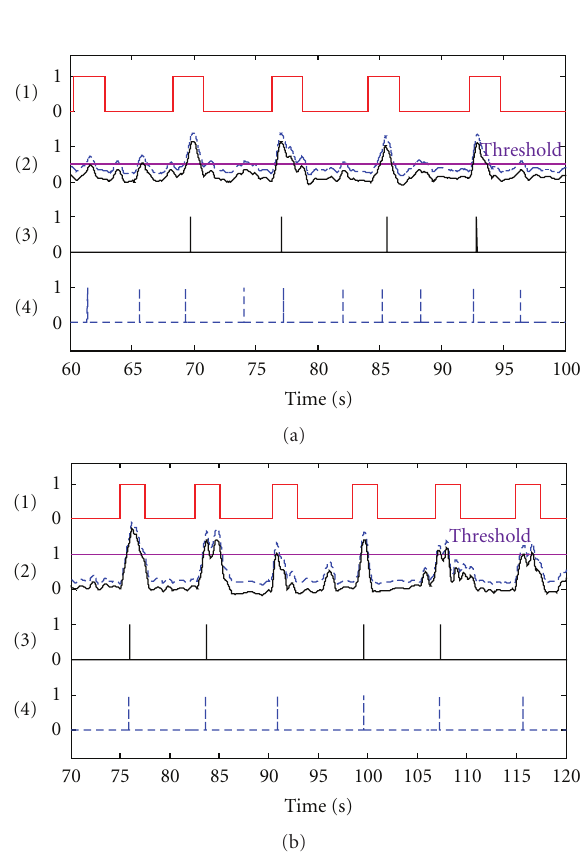
Figure 6: An example of comparison between biased and debiased classification output in detecting the onset of the movement: (1) IC intervals, (2) dashed line: biased classification output and straight line: debiased output. (3) Detected onsets using debiased output and (4) detected onsets using biased output. ((a) the case that debiasing improves the performance by decreasing FP detections, (b) the case that debiasing decreases the